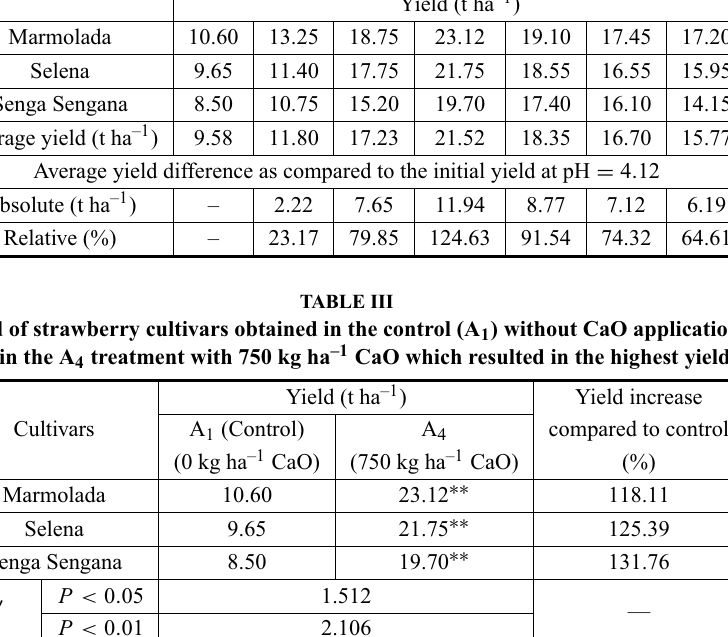
Strawberry yield dynamics as affected by changes in pH. Cultivars